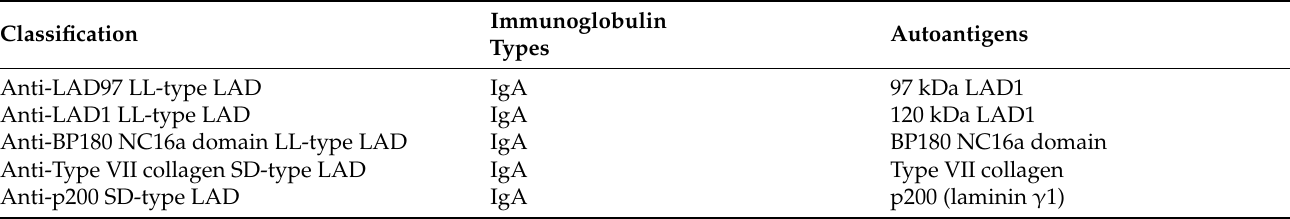
Table 3. Classification and autoantigens of linear IgA disease